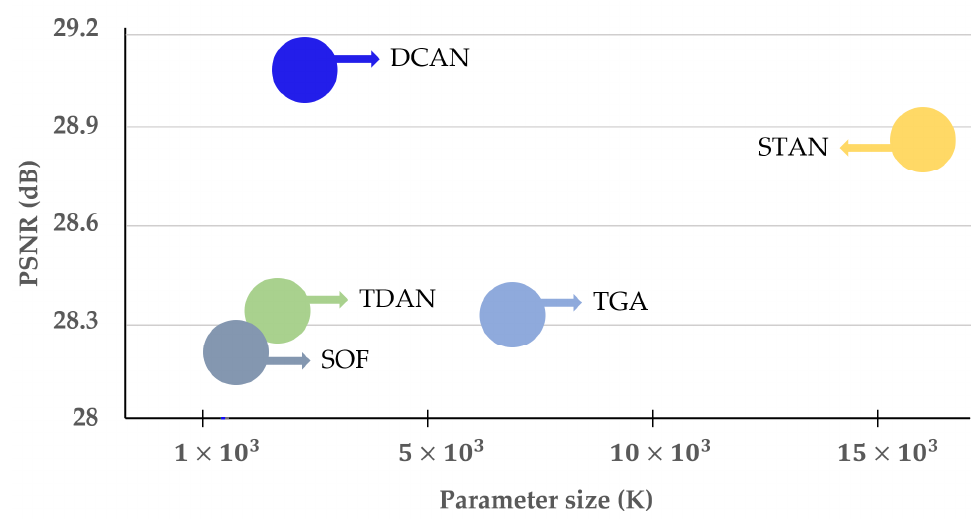
Figure 4. Comparison of network SR performance and complexity between the proposed DCAN and previous methods for the REDS4 test dataset. The x- and y-axes denote the parameter size and PSNR, respectively.